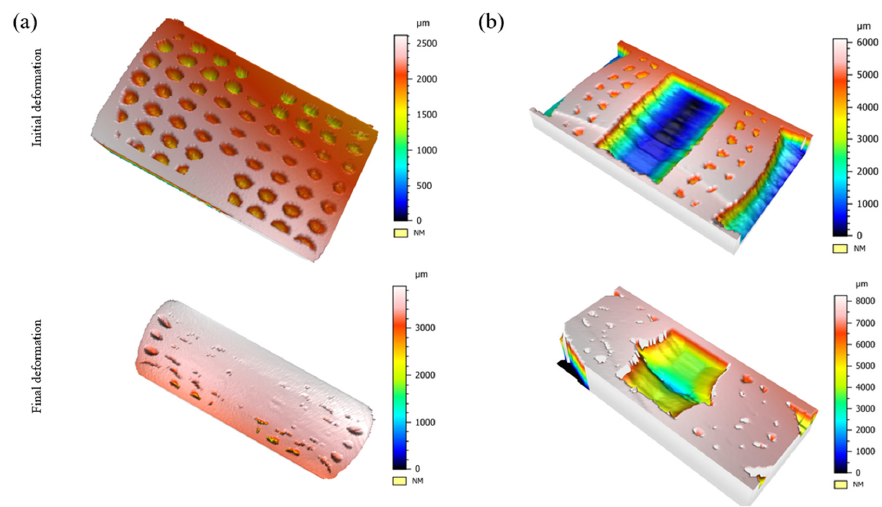
Figure 11. Surface morphology of the deformed specimens produced through optical profilometry. ( a ) Pores. ( b ) Tubes.